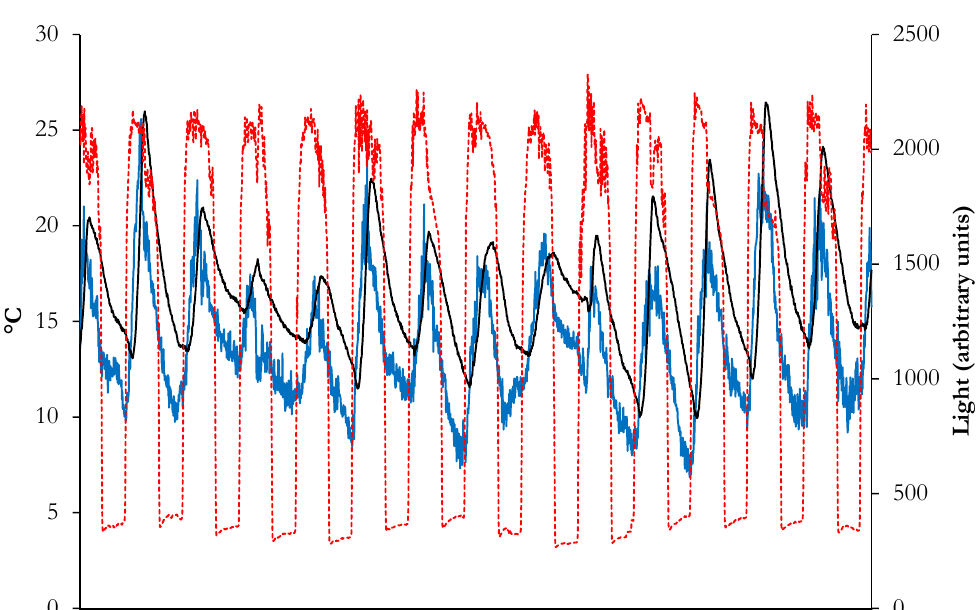
Figure 1. Representative plot of 14 daylight, soil temperature, and air temperature recordings taken during the seedling emergence trials.